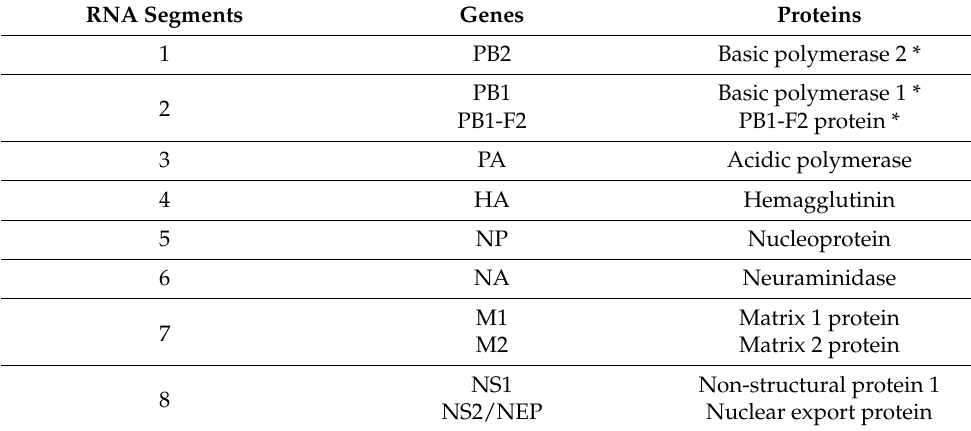
Table 1. IAV genes and proteins they